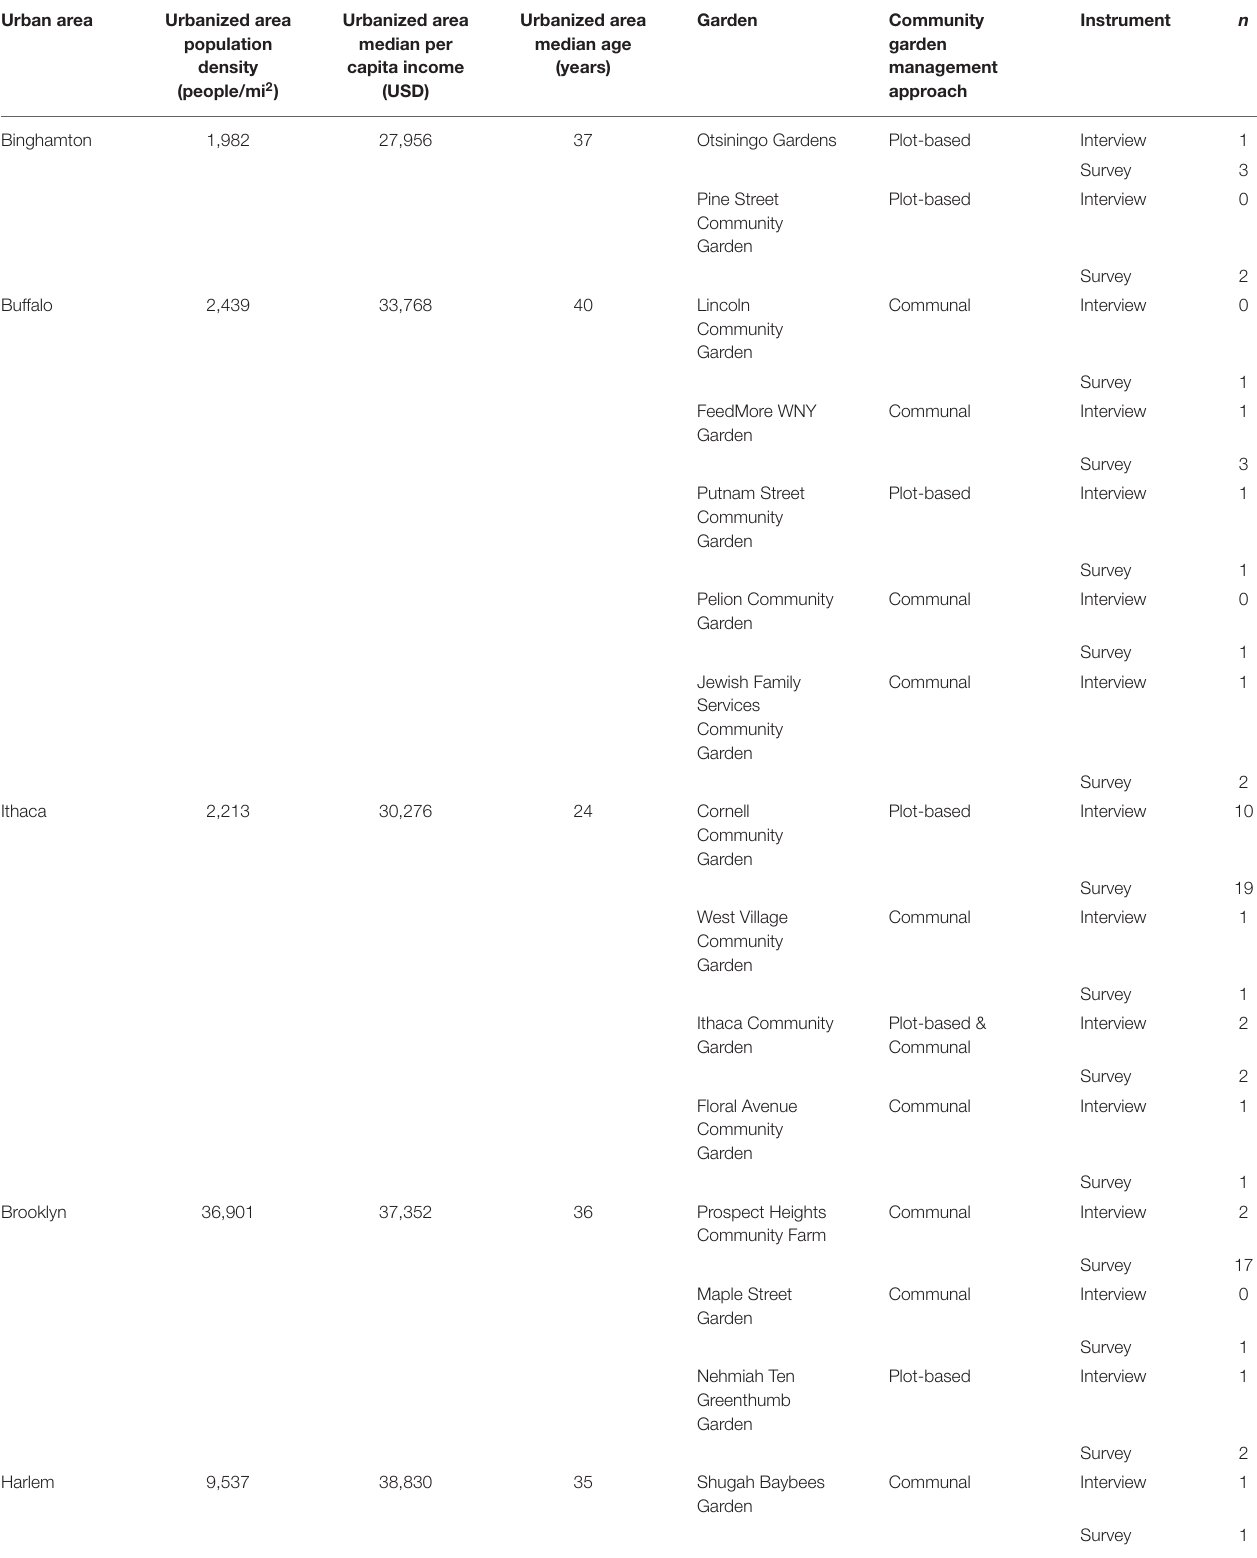
Note that survey and interview participants are not